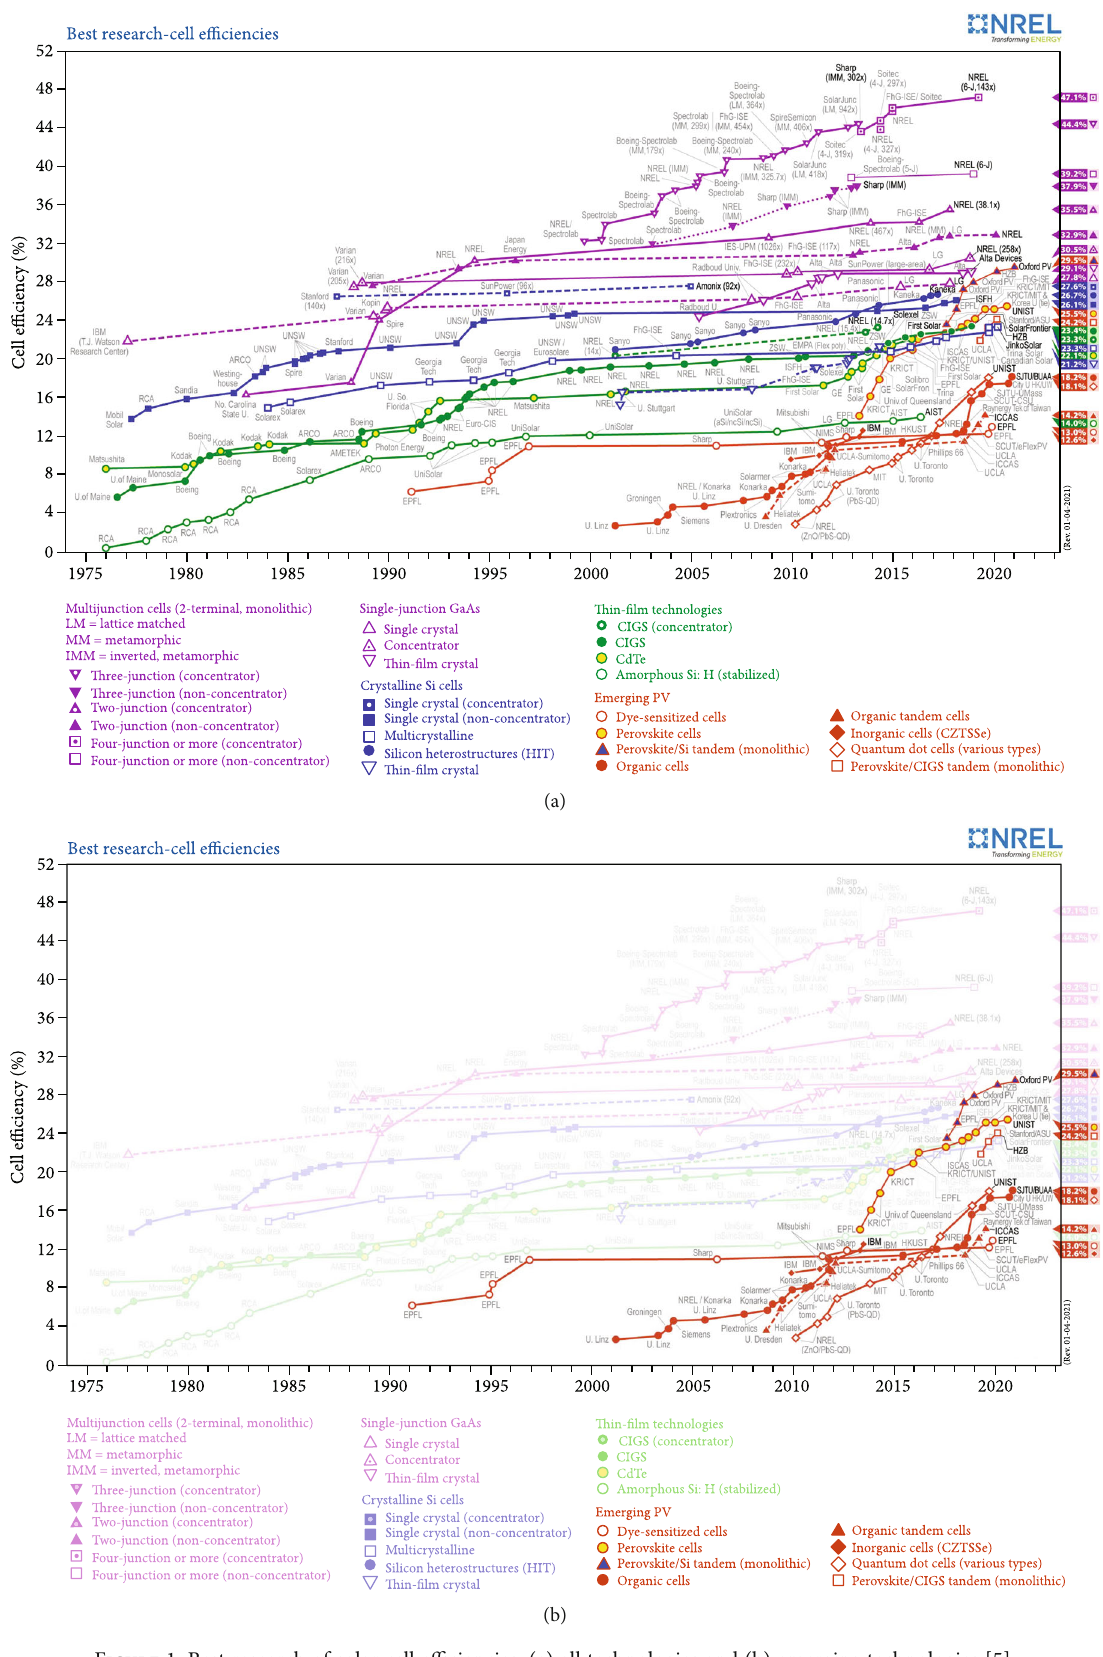
Figure 1: Best research of solar cell e ffi ciencies: (a) all technologies and (b) emerging technologies